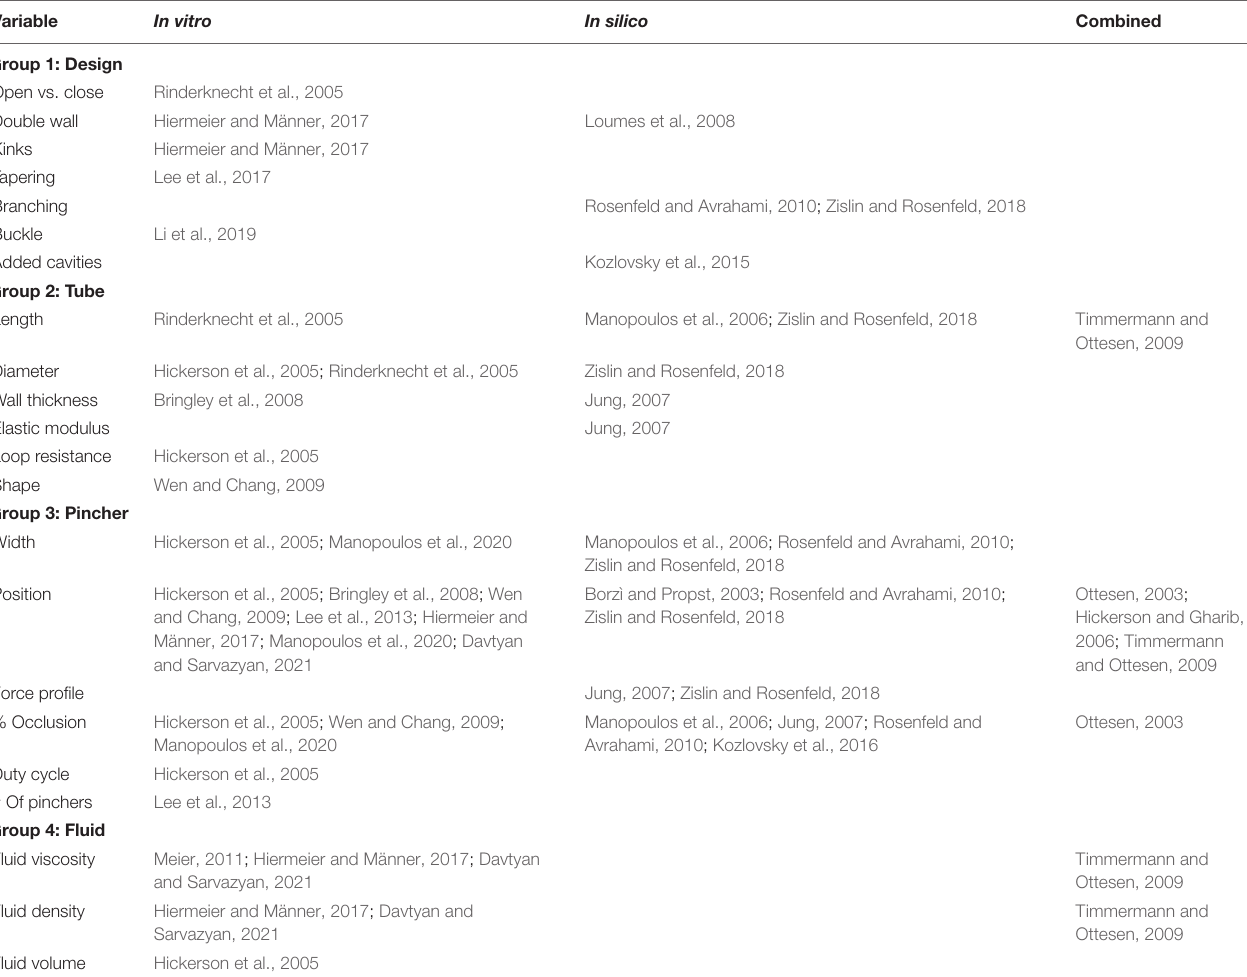
TABLE 1 | Major variables that affect performance of Liebau